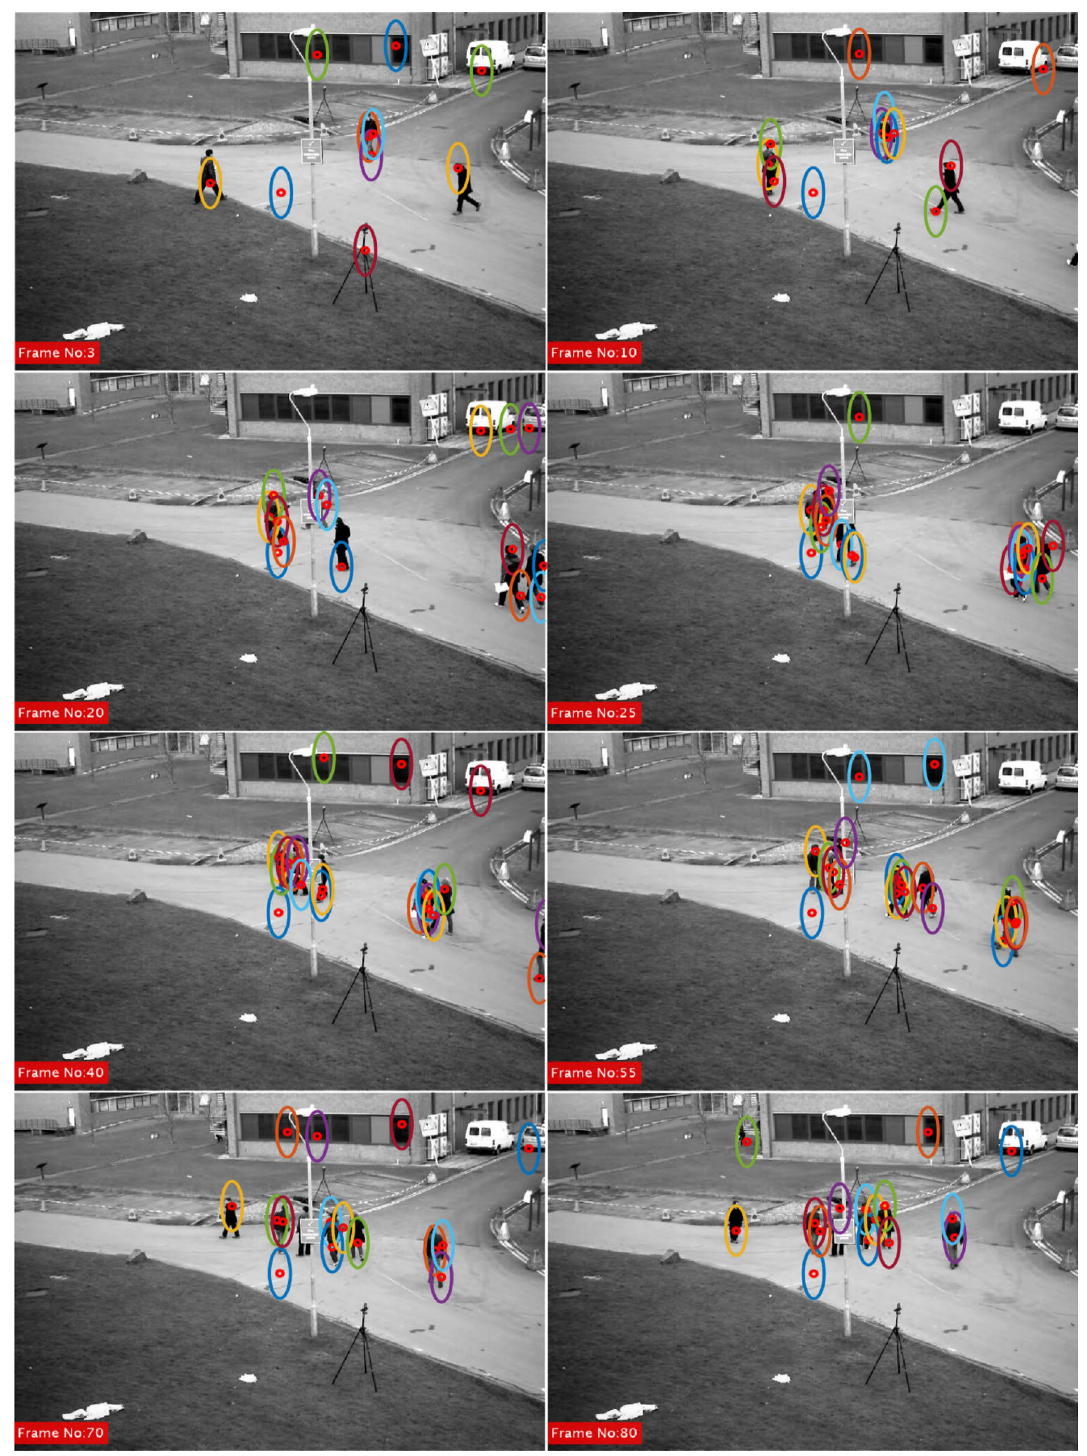
Fig. 5 Simulation results of the proposed intermediate tracker in the frames numbered 3,10, 20, 30, 45, 55, 70, 80 (from up left to down right) of S2.L1 scenario of